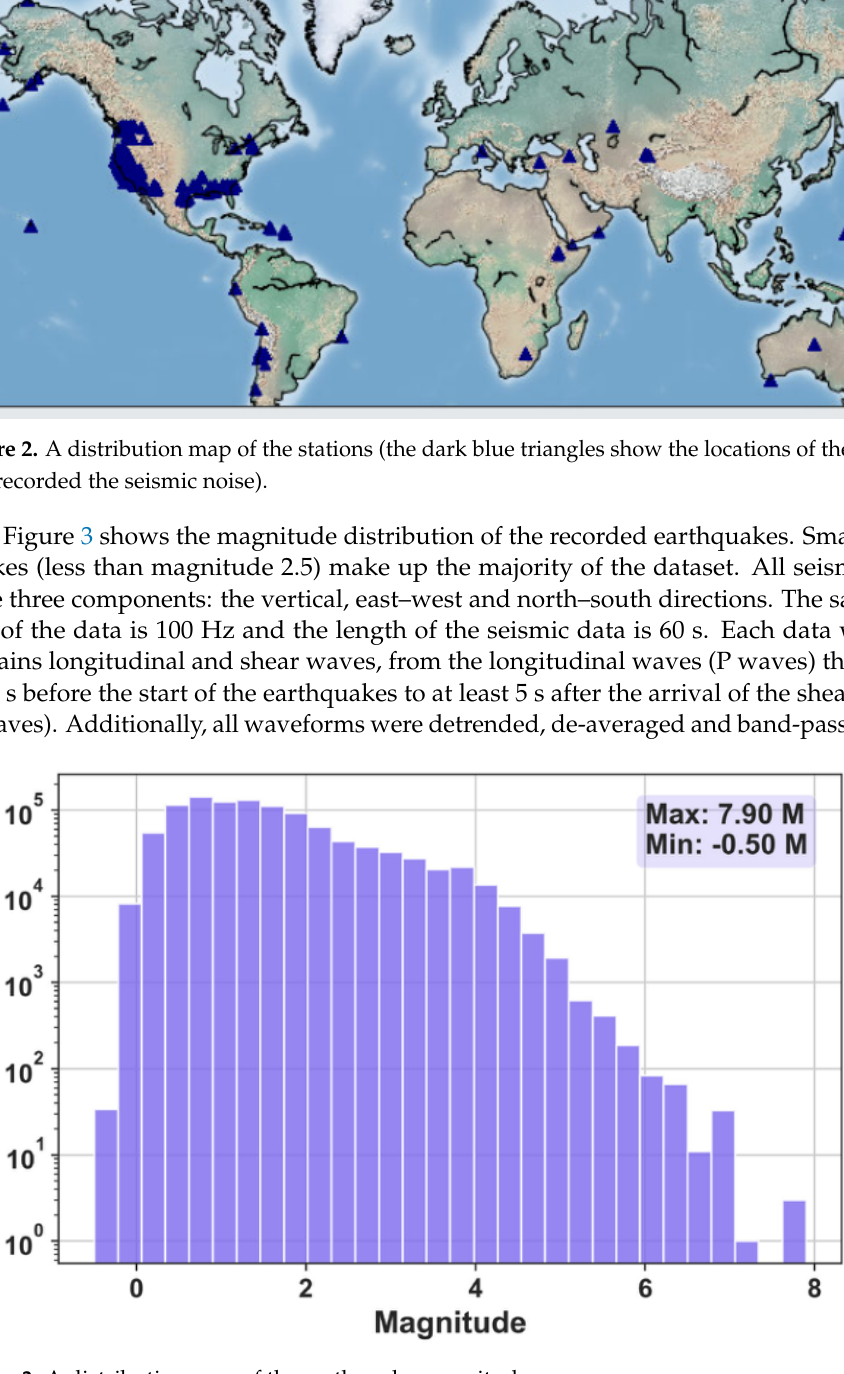
Figure 3. A distribution map of the earthquake